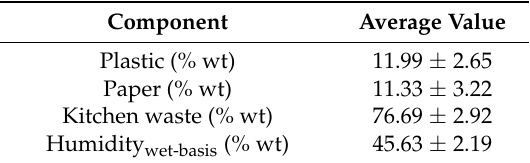
Table 5. MSW composition (sorted by type, wet basis).